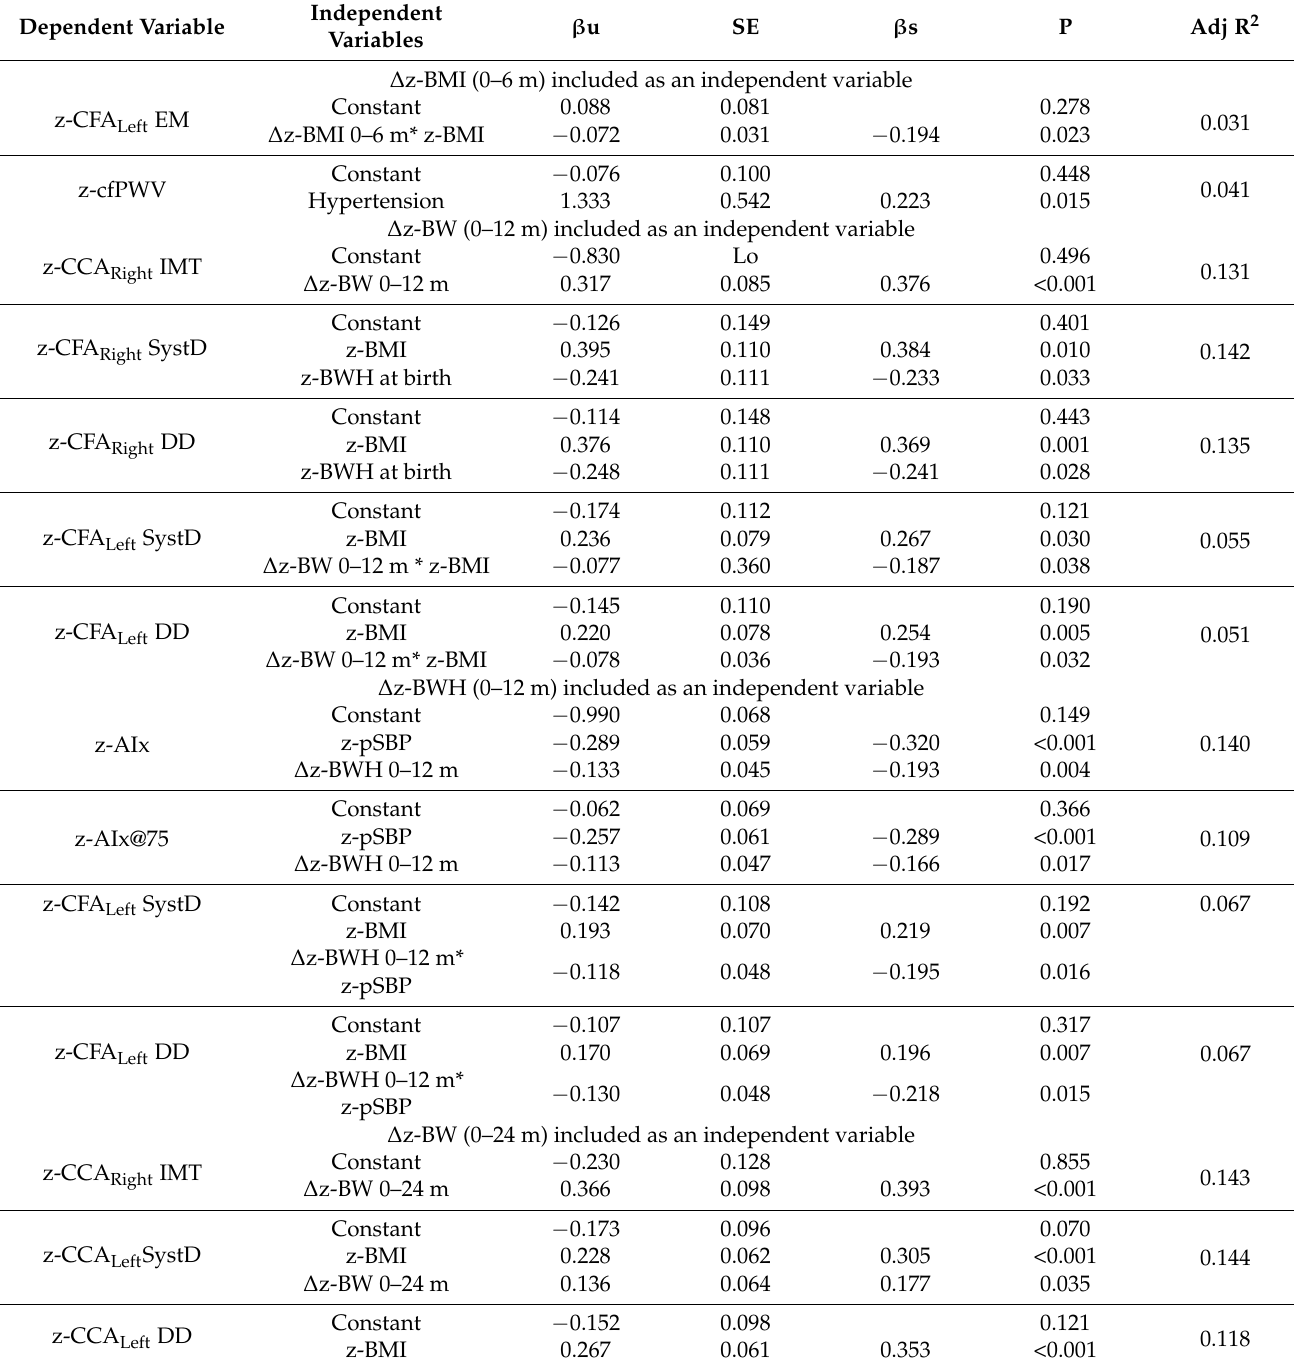
Table 6. Multiple linear regression (MLR) analysis between arterial parameter z-scores at age 6 years (dependent variables) and anthropometric indexes and cardiovascular risk factors (CRFs) (independent